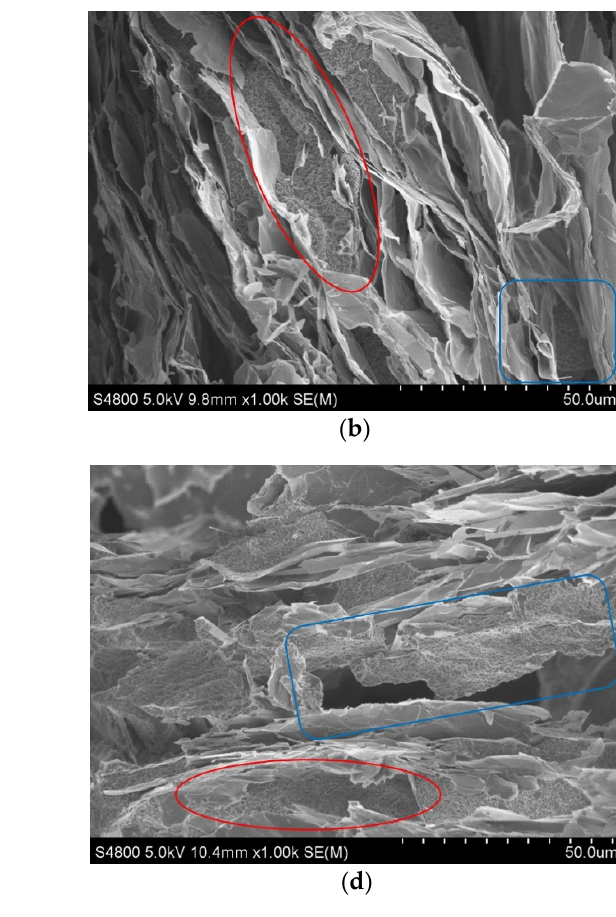
Figure 10. SEM image of KE3 series sample cross-section. ( a ) KE3-1; ( b ) KE3-2; ( c ) KE3-3; and ( d ) KE3-4.